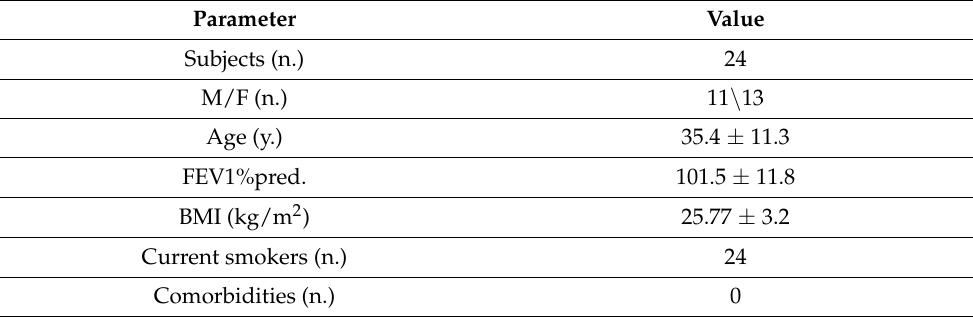
Current smokers (n.) Comorbidities (n.)